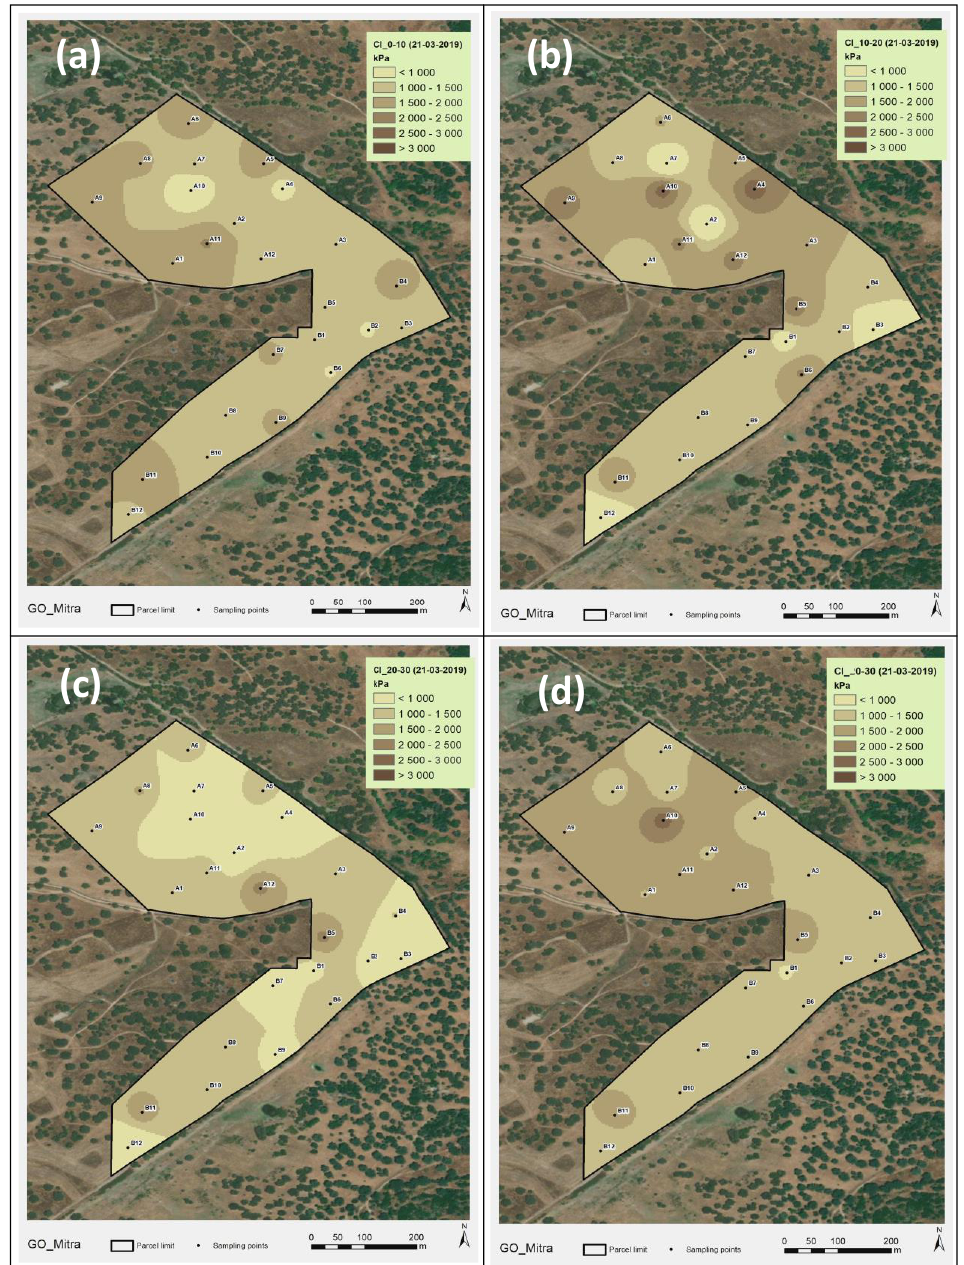
Figure 12. Cone Index (CI) maps of the experimental field in March 2019: ( a ) 0 – 0.10 m; ( b ) (0.10 – 0.20 m; ( c ) 0.20 – 0.30 m; ( d ) 0 – 0.30 m. The descriptive statistics of the SMC and CI relative to all data obtained between September 2021 and March 2022 are presented in Table 3. The results of the ANOVA ap- plied to the CI measurements are also presented. This analysis shows significant